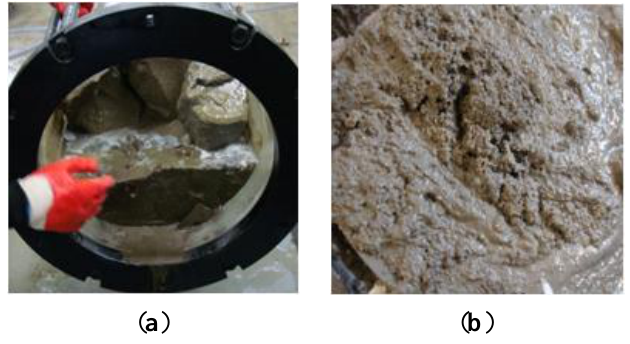
Figure 10. Segregation. ( a ) entrance to the precipitation of cement; ( b ) segregated inlet sand.